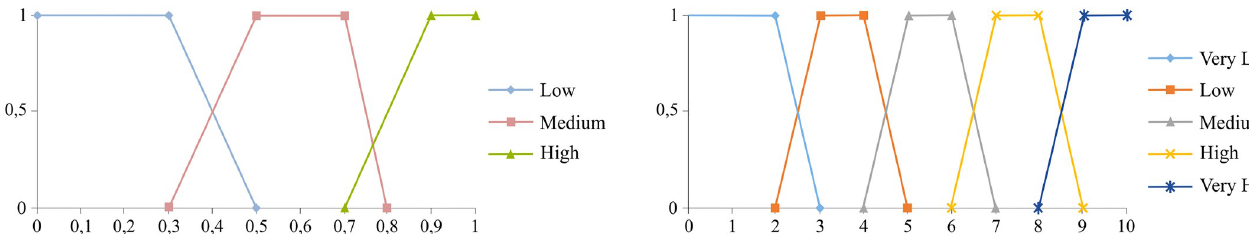
Fig 6. Partition of the domain of input (left) and output (right) variables of the evaluation model.